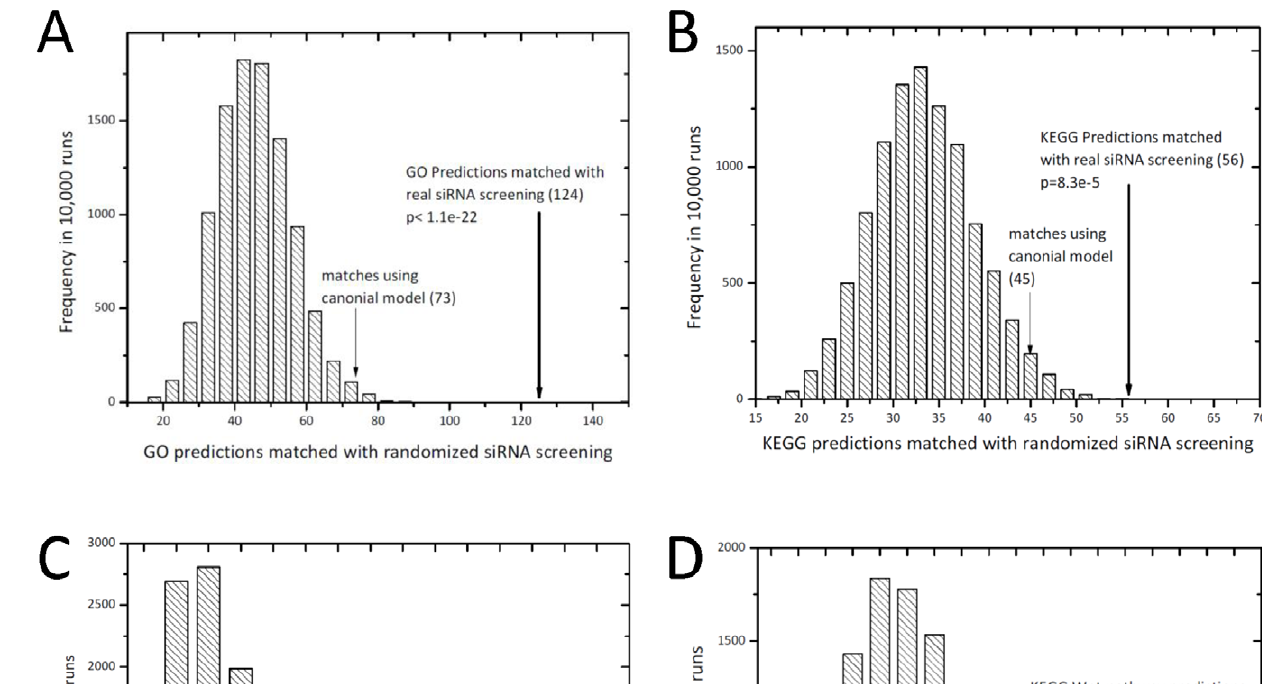
Figure 5. Comparison between GO term/KEGG pathway prediction and DRSC RNAi screening hits. A–B , GO/KEGG predictions matched with RNAi screen results compared to randomized RNAi screen data. C–E , individual pathway/function predictions matched with RNAi screen results compared to randomized RNAi screen data. For comparison, we show performance of a supervised machine-learning model trained using the same algorithm and datasets except that it aggregates all GO terms/KEGG pathways in its training as has been traditionally done.